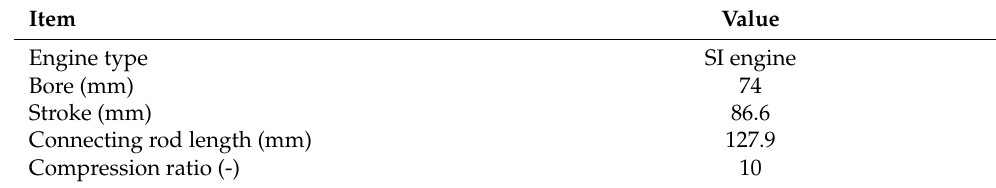
Table 2. Engine type and